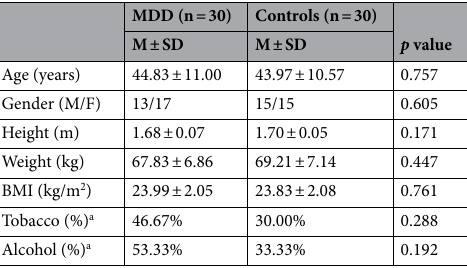
Table1. Demographic characteristics of MDD and controls. a Chi-square test; compared with HCs, p < 0.05; BMI body mass index.